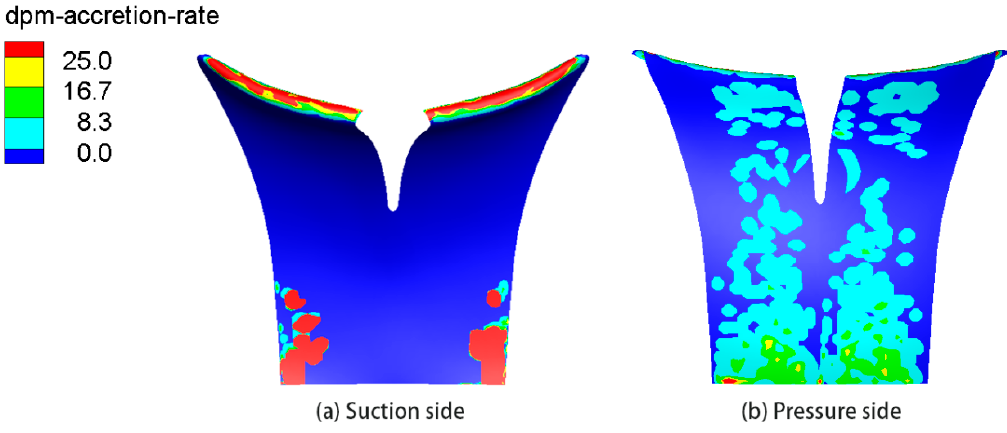
Figure 25. Accretion rate on the prototype blade surface (units: kg/s).